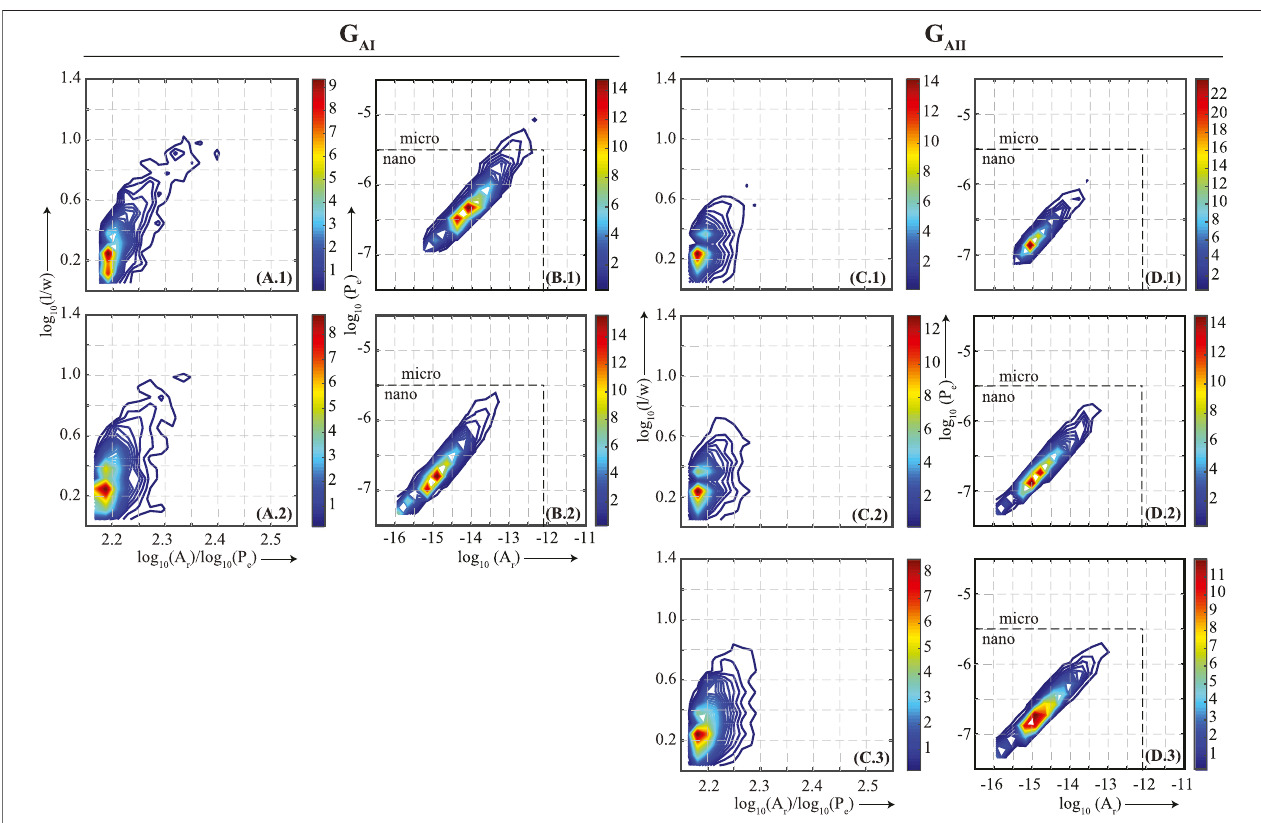
FIGURE5| Facies A . Contoured histograms ofpore l,w, A r ,and P e arebinnedand plottedalongthelines of Figure 3C to visualize pore-shape ( A.1-2 and C.1 – 3 ) and Figure 3D to visualize pore-size ( B.1-2 and D.1 – 3 ) distributions. Based on the pore-shape distribution, samples are classi fi ed into two groups, G AI ( A.1-2 and B.1 – 2 ) and G AII ( C.1-3 and D.1 – 3 ). In (A) – (D) , warm color indicates higher pore population. In ( B.1 – 2 ) and ( D.1 – 3 ), a dashed line separates micro- (1 – 62.5 µm) and nano- (1 nm-1 µm) pores. Sample depth, porosity, composition and gradients for P- (r P ), S1- (r S1 ) and S2- (r S2 ) waves are mentioned in the Table 1 . The fi gure indicates that within the same pore-shape distribution, r P increases as the dominant pore-size